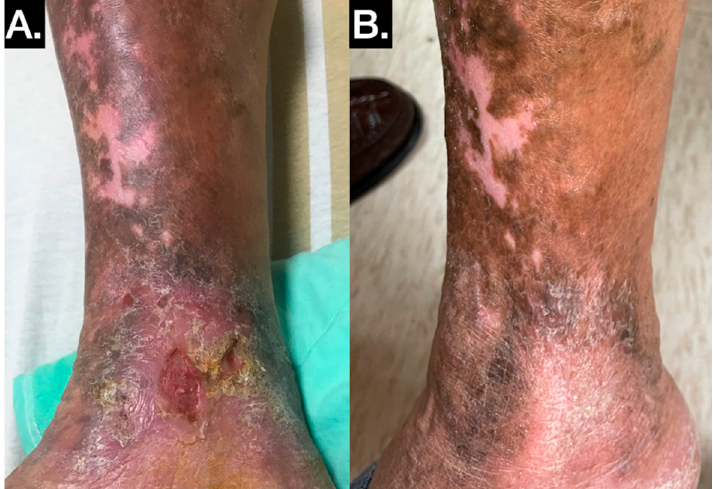
Figure 2 . Typical stasis leg ulcer with venous reflux in the gaiter area. ( A ) Wet and nonhealing stasis leg ulcer. ( B ) Stasis leg ulcer healed after truncal ablation by ARC catheter. The 18 patients in the nonreflux group are summarized in Tables 1 and 2. Four pa- tients with SLUs had congenital anomalies (double IVC and situs inversus), three pre- sented with vascular compression (May–Thurner syndrome), three had SLUs related to illegal drug addiction, and six had SLUs involving both legs (33.3%). Most patients in the nonreflux group received coumadin or nonvitamin K antagonist oral anticoagulants (NO- ACs), and two of them underwent angioplasty for iliac vein lesions (Figure 3). Figure 3. Typical triggered angiography noncontrast enhanced (TRANCE) magnetic resonance imaging (MRI) evaluation for patients with illegal-drug-use-associated stasis leg ulcers (see also